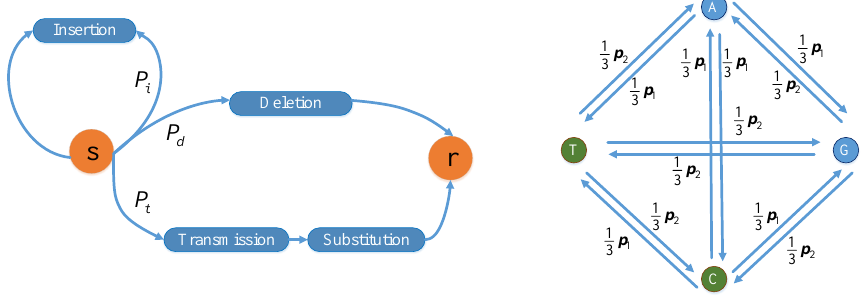
Figure 1. DNA channel model based on Illumina sequencing. s , input base; r , output base.